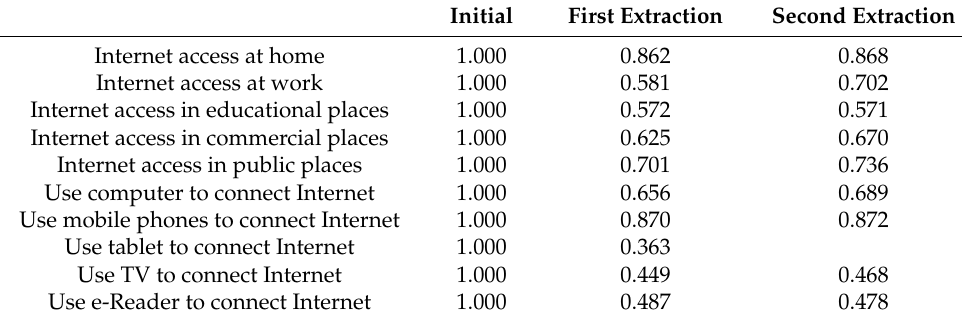
Table 3. Communalities from factor analysis in ICT use. Source: own